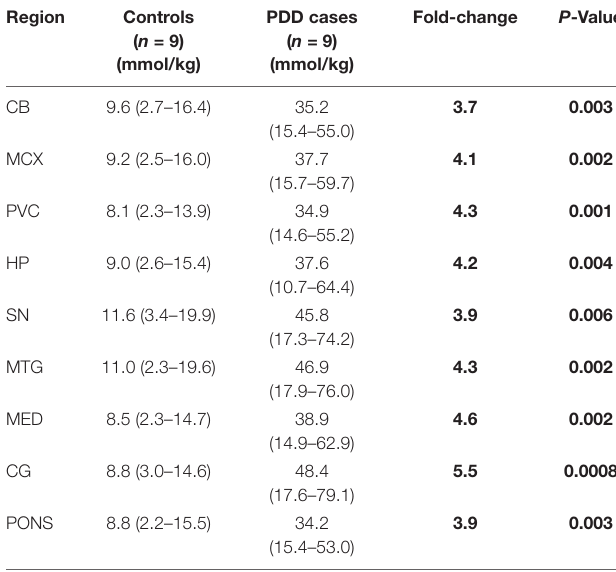
TABLE 1 | Tissue urea concentrations in PDD cases and